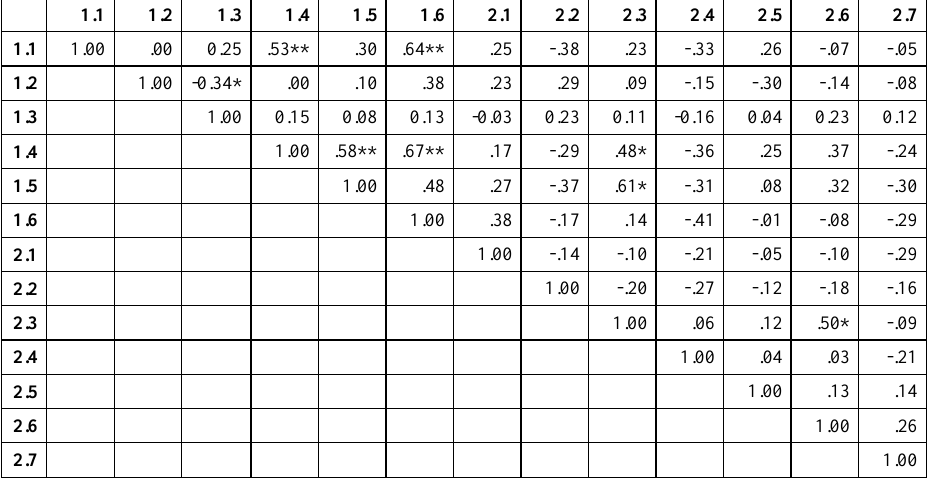
Table 3 : The Correlation